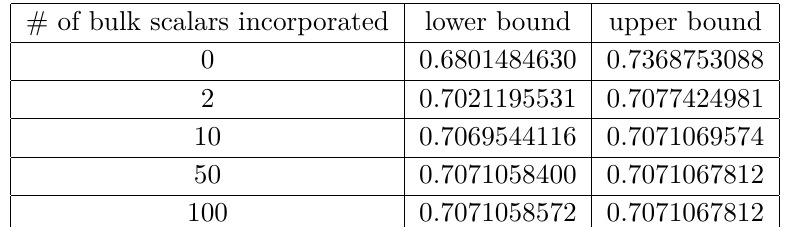
= 0 . 7071067811865 . . . 2